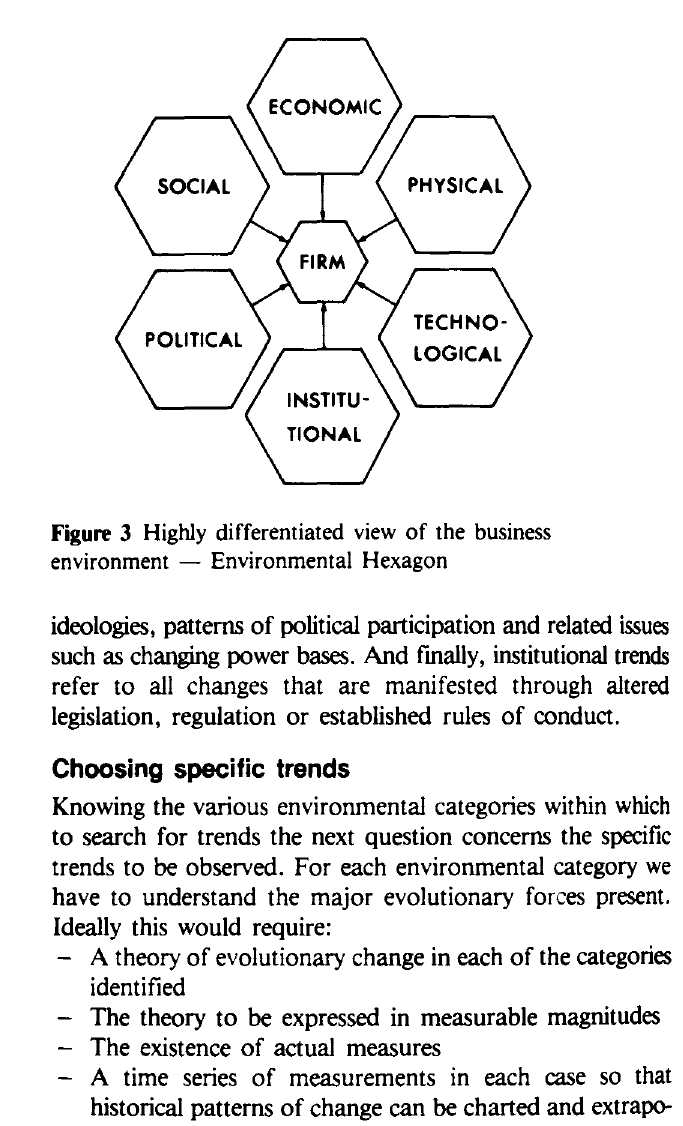
Figure 1 Undifferentiated view of the business environment